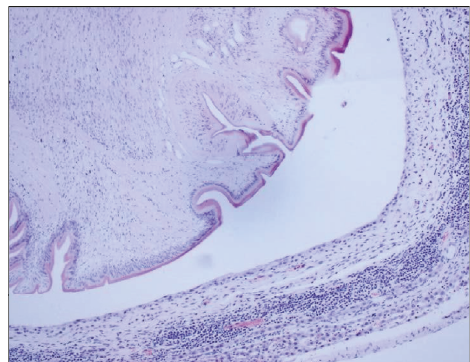
Figure 3: Section of liver of Rattus norvegicus showing thick capsule with mononuclear cell Infiltration around a Cysticercus